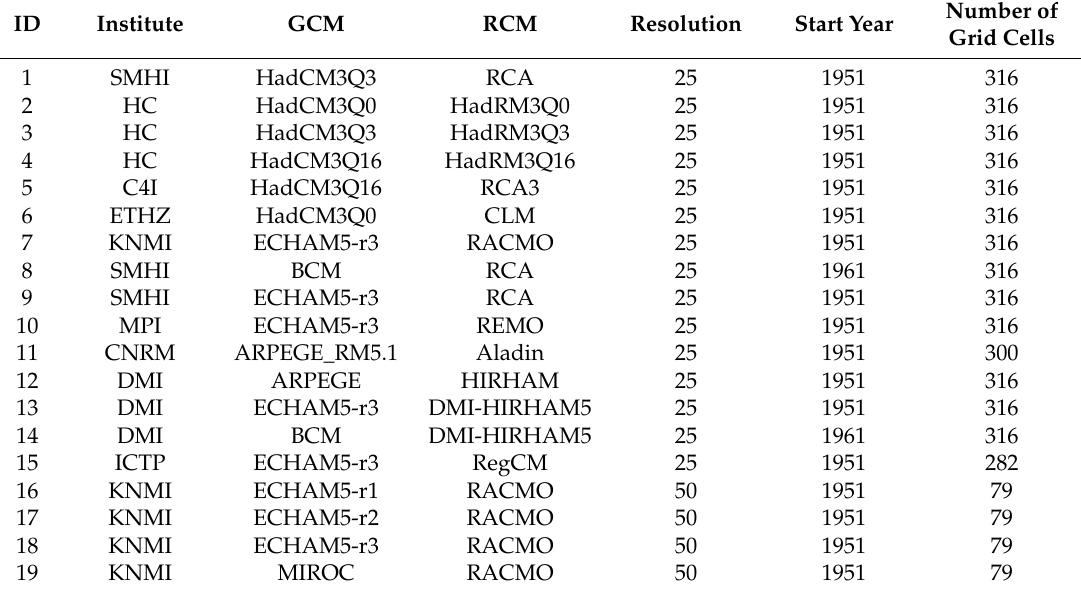
Table 4. Numbering of the chosen climate scenarios as combinations of General Circulation Models (GCMs) and Regional Climate Models (RCMs), the responsible institute, resolution [km], starting year, and number of grid cells used for interpolation of the projected climate in the Elbe